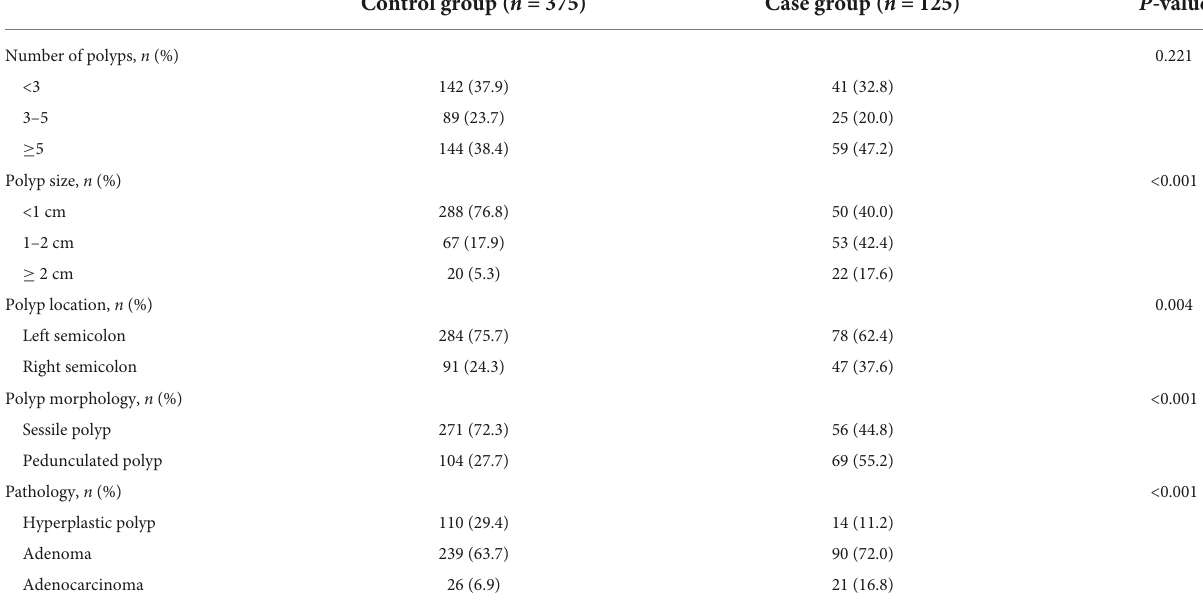
TABLE 2 Comparison of polyp-related factors of delayed post-polypectomy bleeding in two groups. Control group ( n =